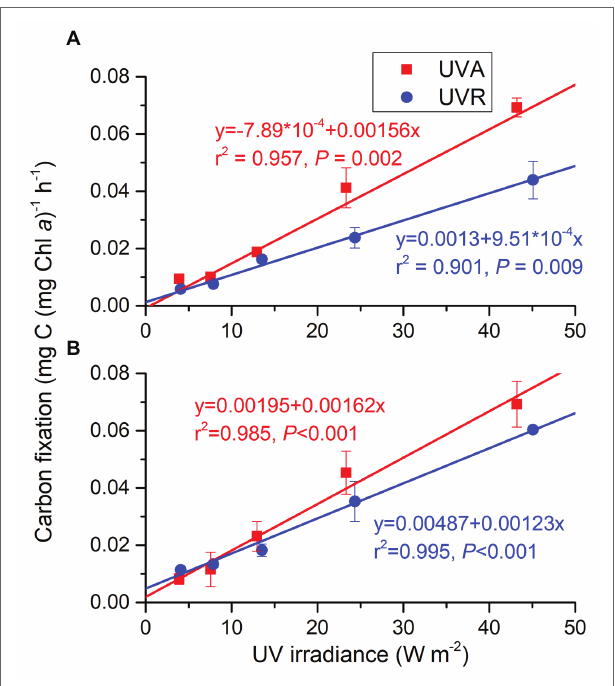
FIGURE 6 | Carbon fixation rates of S. costatum grown at ambient (A) and lowered CO 2 (B) levels when exposed to UVA or UVR (UVA + UVB). The error bars indicate the SDs ( n =